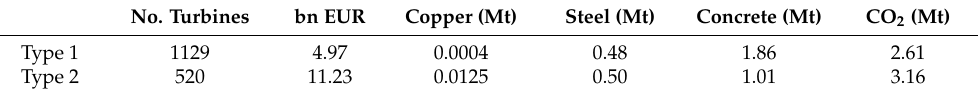
Table A3. Demand for the electric mobility in terms of onshore/offshore turbines. No. Turbines